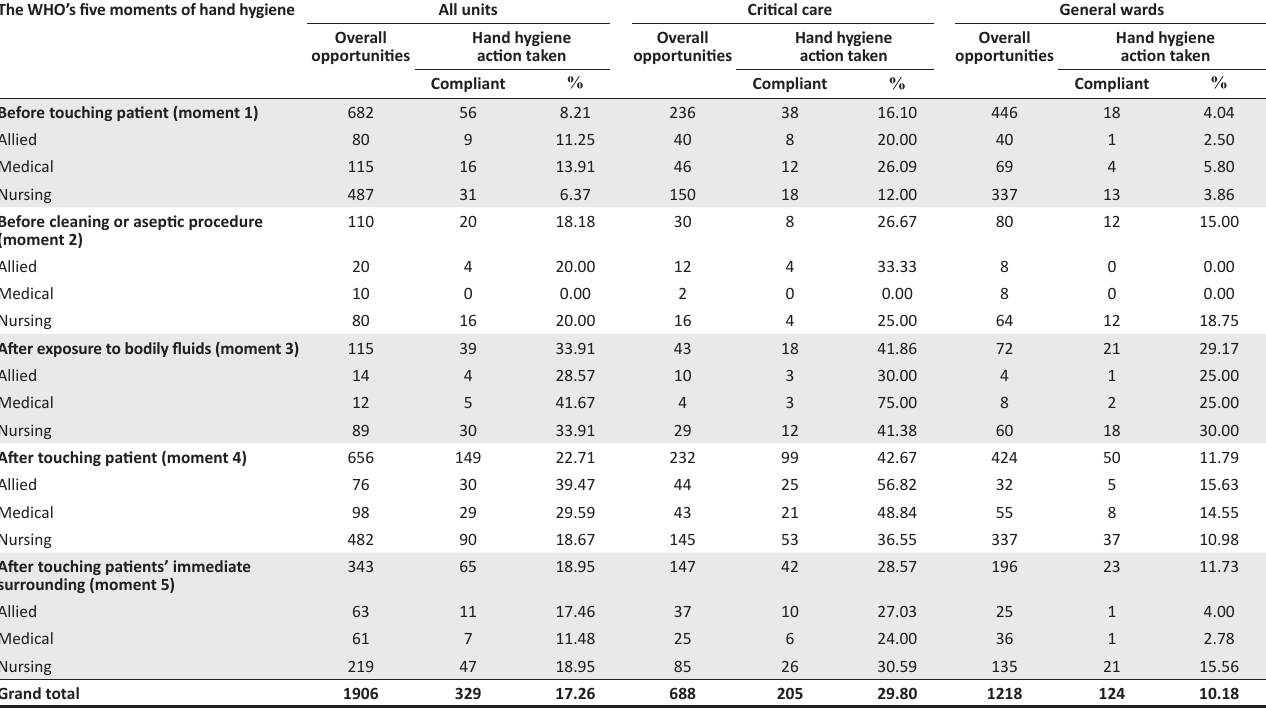
TABLE 1: Observed compliance with the World Health Organization’s five moments of hand hygiene (overall study and comparison between critical care and general wards). The WHO’s five moments of hand hygiene All